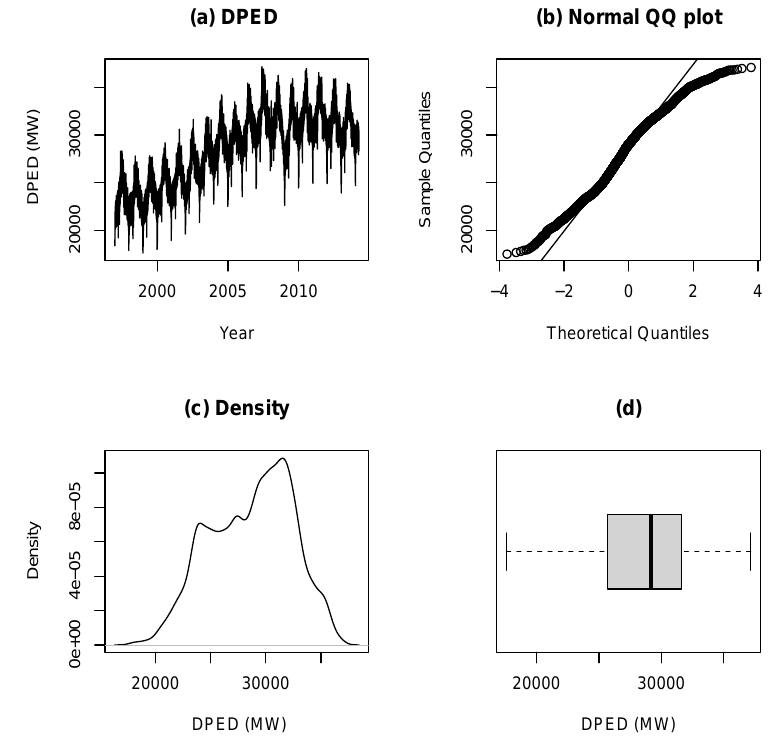
Figure 1. DPED plot ( a ), Q-Q plot ( b ), density plot ( c ) and box plot ( d ).